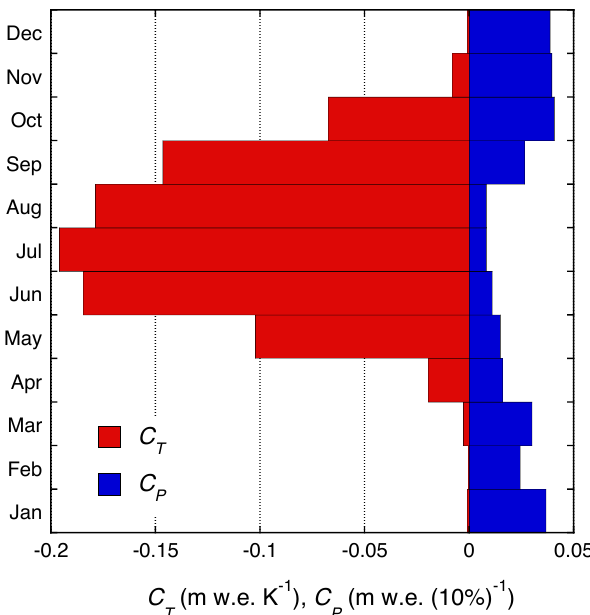
Fig. 8. Seasonal sensitivity characteristic of Hardangerjøkulen, showing the mass balance sensitivity to monthly perturbations in local air temperature and precipitation for the period 1961–1990. The monthly values were normalized to a period of 30 days.